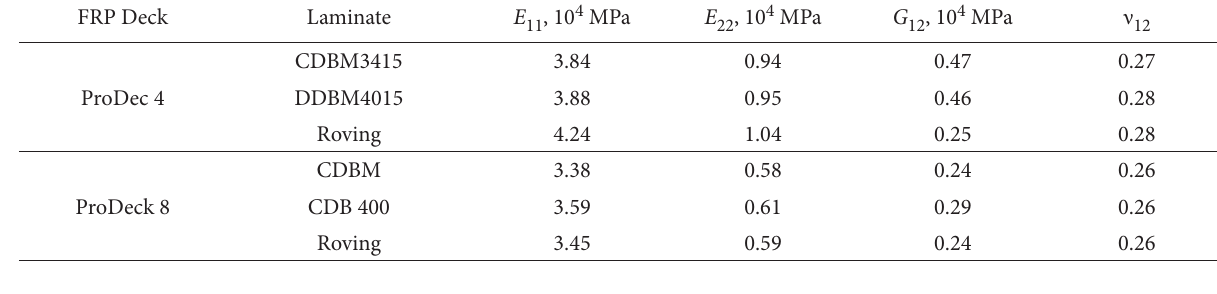
Table 1. Mechanical properties of laminates used for ProDeck 4 and ProDeck 8 FRP Deck